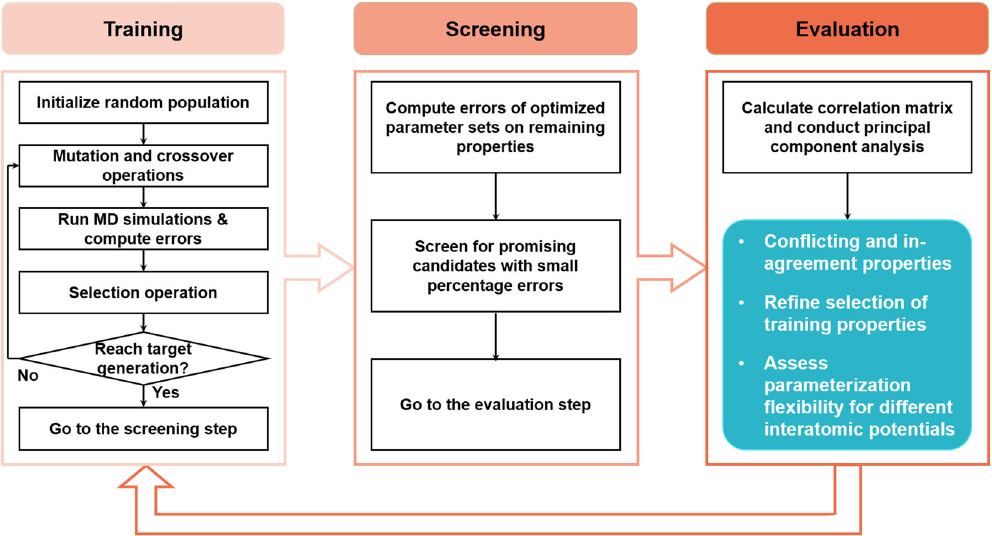
Fig. 1 Schematic of interatomic potential parametrization approach. In the training step, the multi-objective genetic algorithm NSGA-III is used to optimize the parameters of the interatomic potentials for the training properties (Fig. 2). MD simulations are integrated into the genetic algorithm work fl ow for the evaluation of errors. After reaching a prede fi ned number of generations, the optimization terminates, and the optimized parameters are passed to the screening step for the evaluation of the screening properties (Fig. 2). The training and screening properties together are considered for the selection of promising candidates with percentage errors for all properties within a user-speci fi ed threshold. Meanwhile, correlation and principal component analyses are carried out in the evaluation step to reveal the correlation relationships between properties and the performance of interatomic potentials. This information guides the selection of training properties for the next iteration of